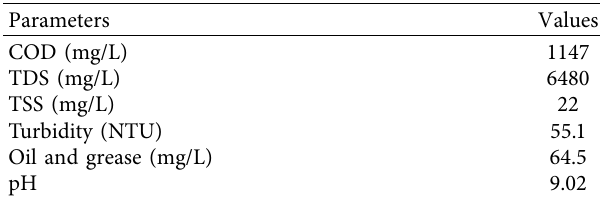
Table 1: Initial composition of